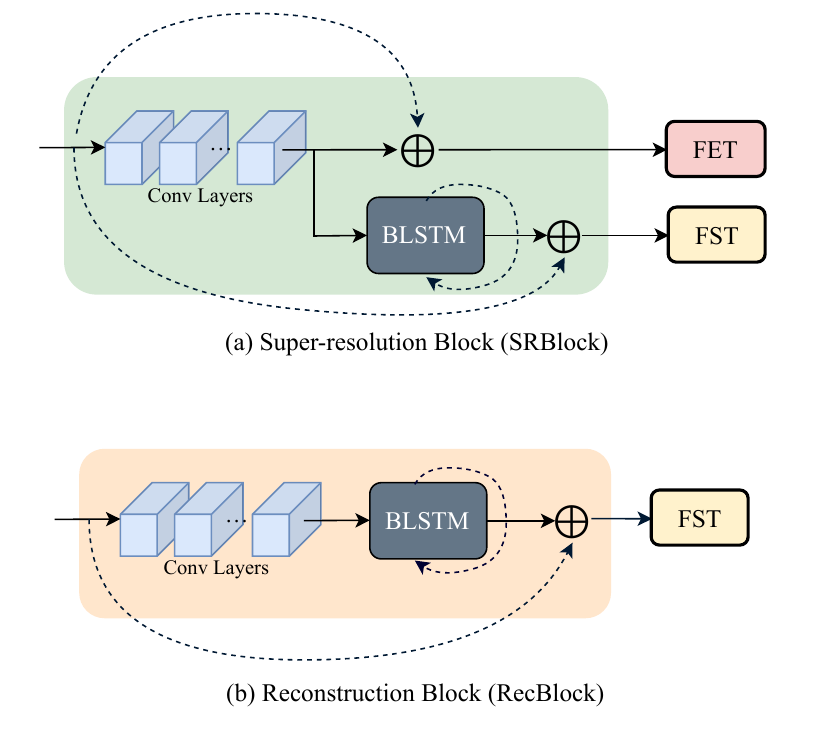
Figure 3. SRBlocks and RecBlocks are feature extractors for the Reconstruction and SR branches, respectively. The Convolutional layers in the SRBlock and RecBlocks are both based on EDSR